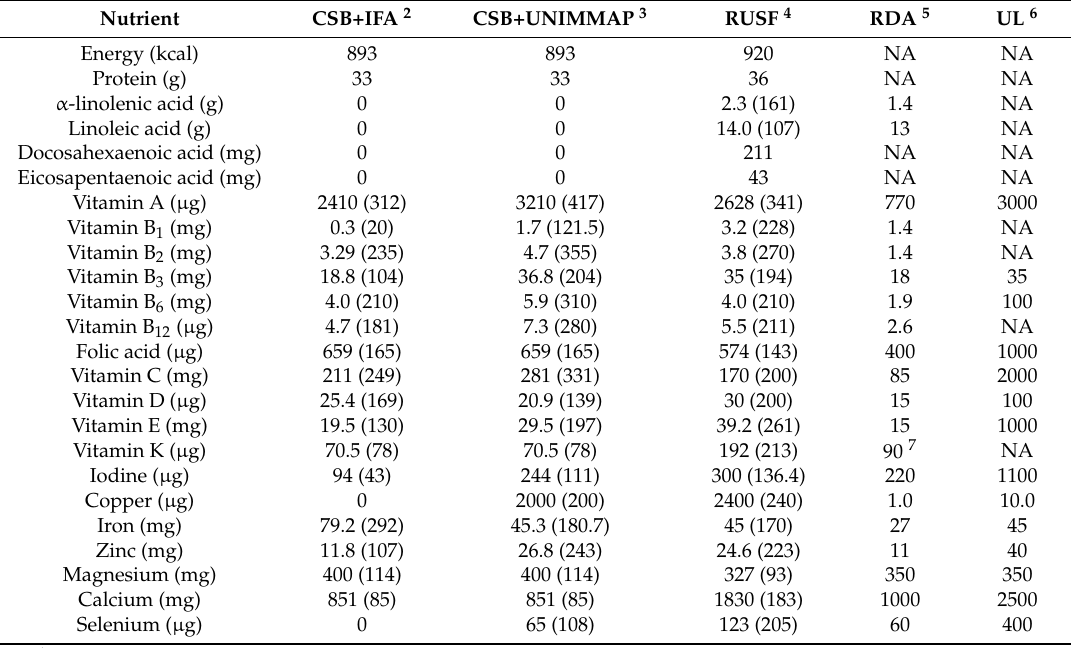
Table 1. Nutrient comparison by treatment group 1